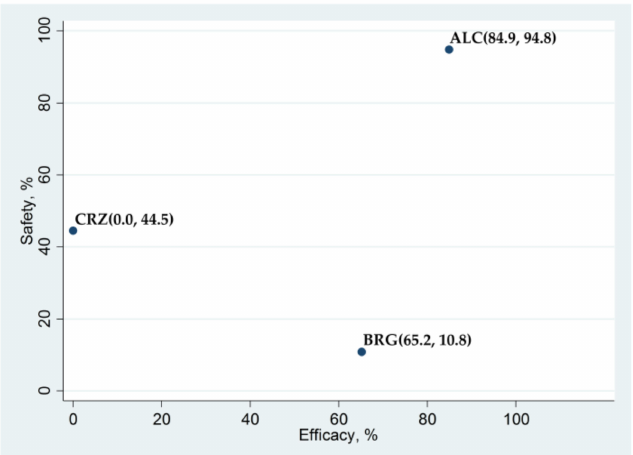
Figure 6. A scatter plot of the surface under the cumulative ranking (SUCRA) values of the e ffi cacy and safety of three anaplastic lymphoma kinase (ALK) inhibitors in terms of progression-free survival (e ffi cacy) and G3–5AAEs (safety) for the overall patient population. Data are presented as (SUCRA